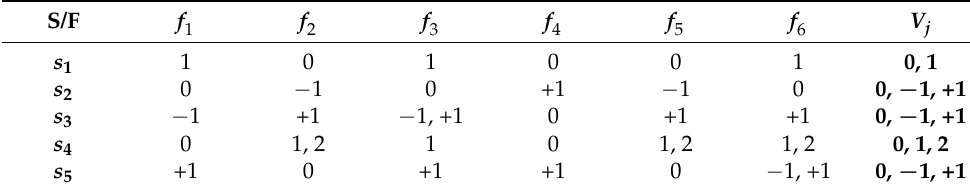
Table 1. Example of